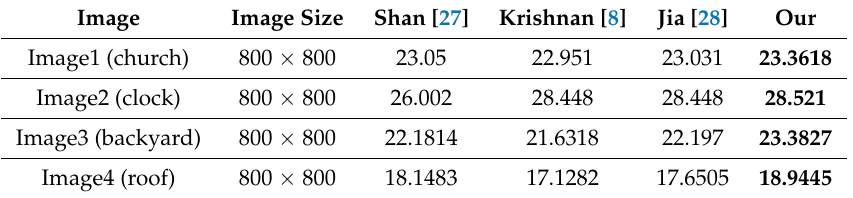
Table 3. Comparison on four images from a real-world benchmark dataset. PSNR values of the debluring images by different